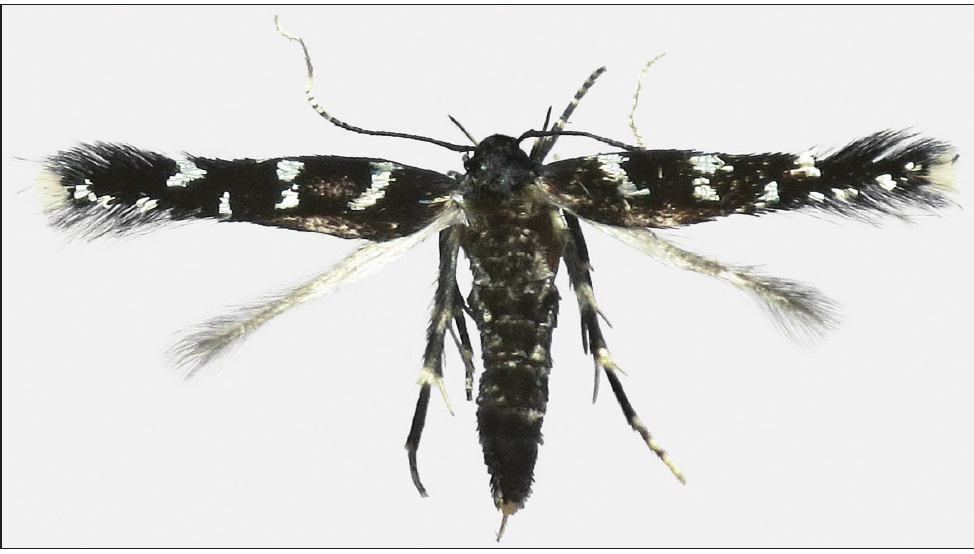
Figure 1. Eulamprotes gemerensis , female.